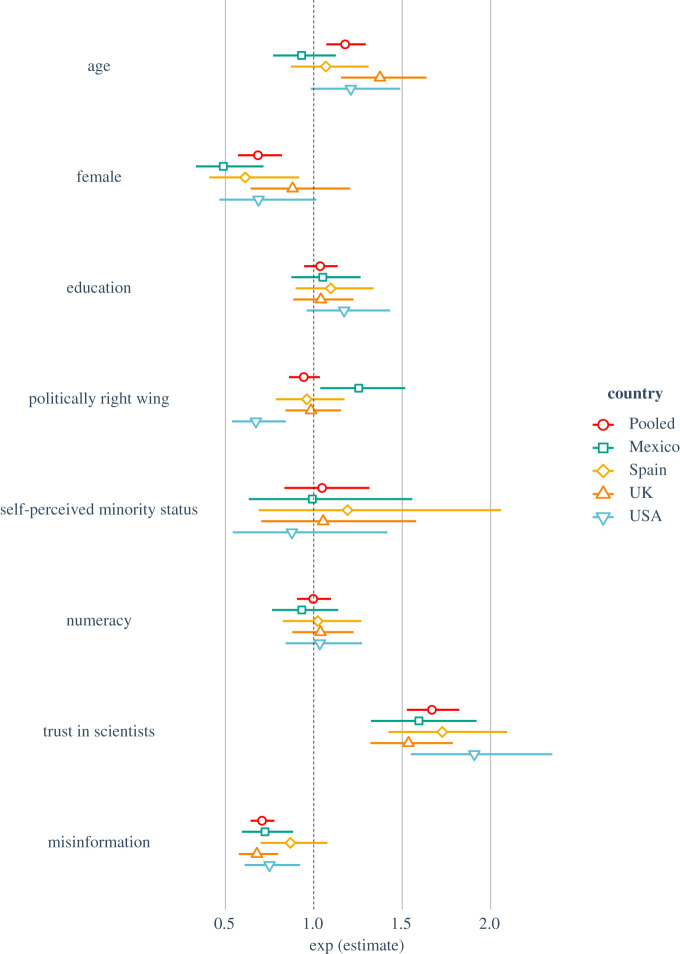
Logistic regression model for ‘Would you get vaccinated against COVID-19 (y/n)’ by country. Note: coefficients are exponentiated and represent odds ratios. Left of the dotted line (i.e. values less than 1) indicates reduced likelihood to get vaccinated.